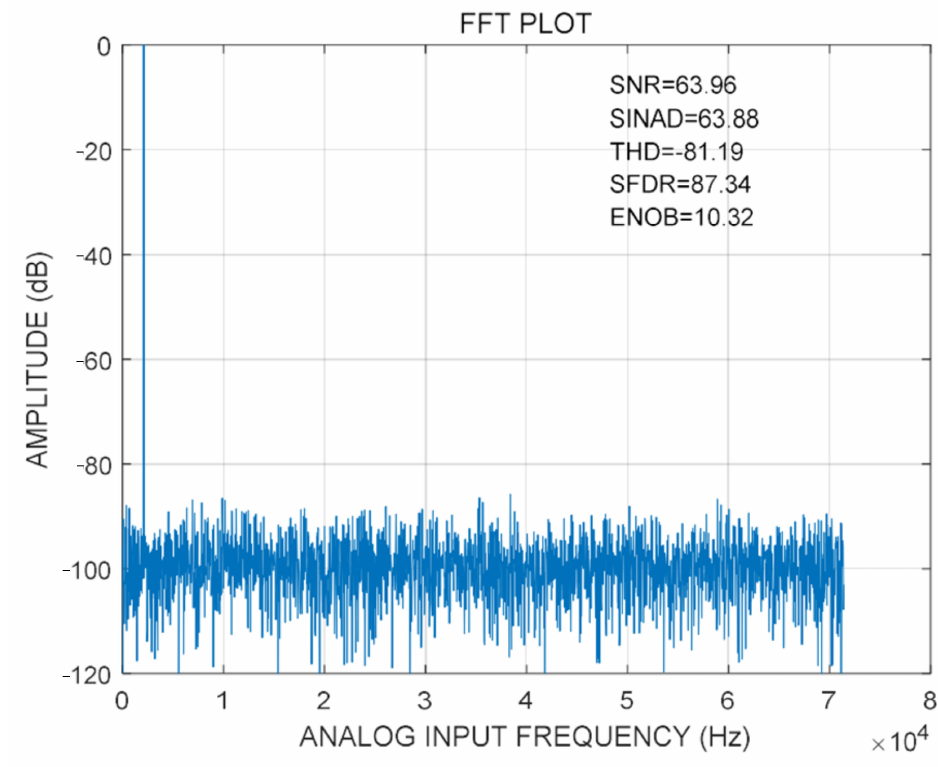
Figure 10. Simulation of 12-bit SAR